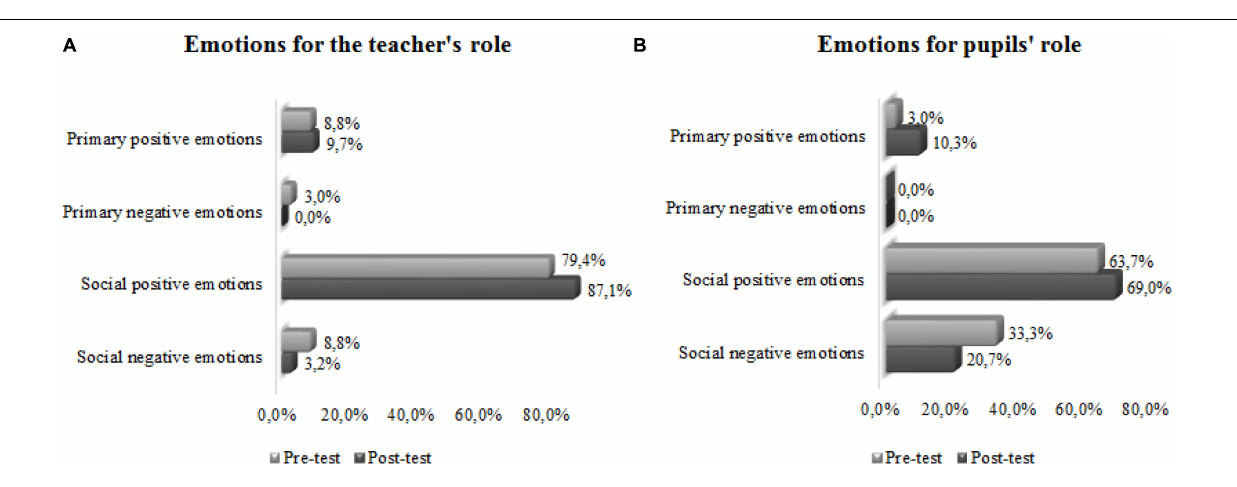
Frontiers in Psychology |